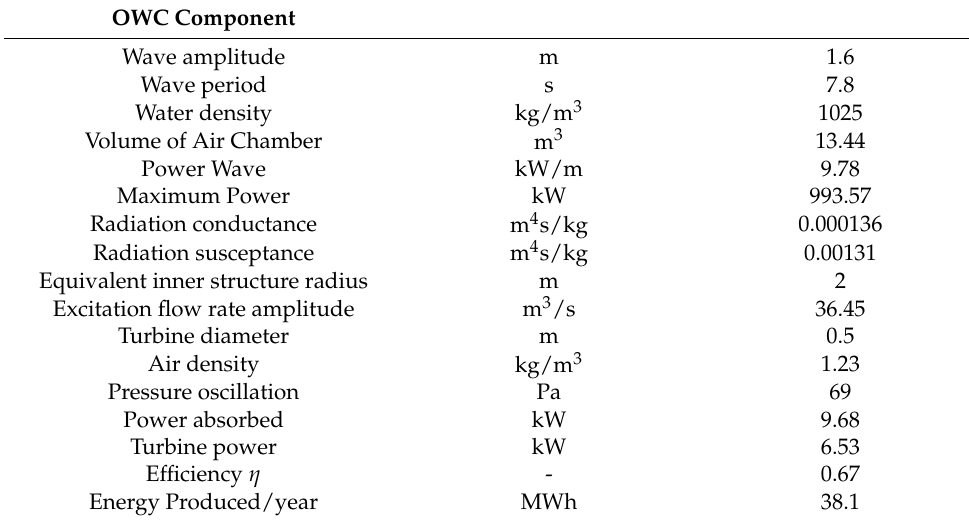
Table 8. Oscillating water column design parameters.